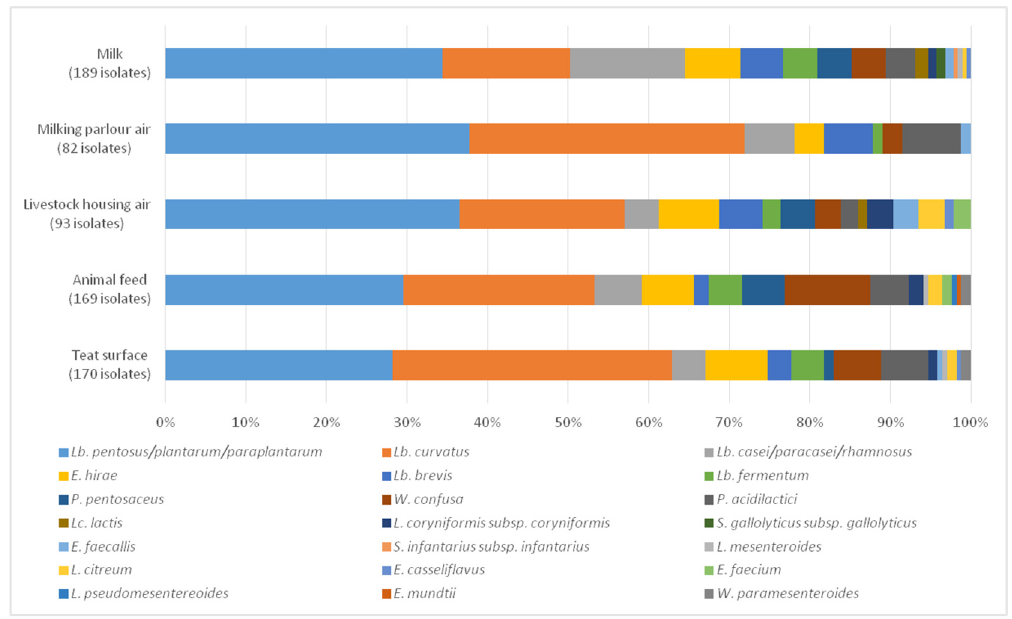
Figure 1. Percentage of each of the species present in the different samples analysed.